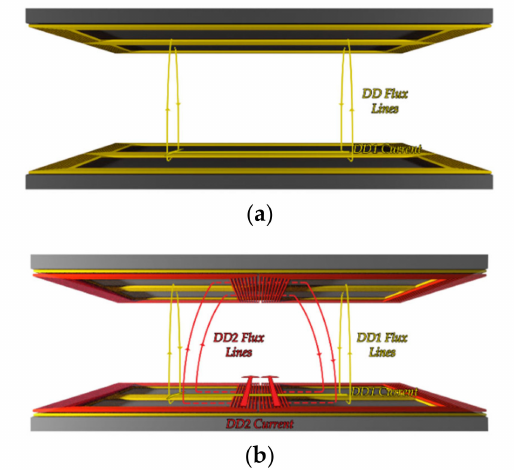
Figure 2. Magnetic flux lines between the transmitter and the receiver pad: ( a ) with single DD coil structure; ( b ) with double DD coil